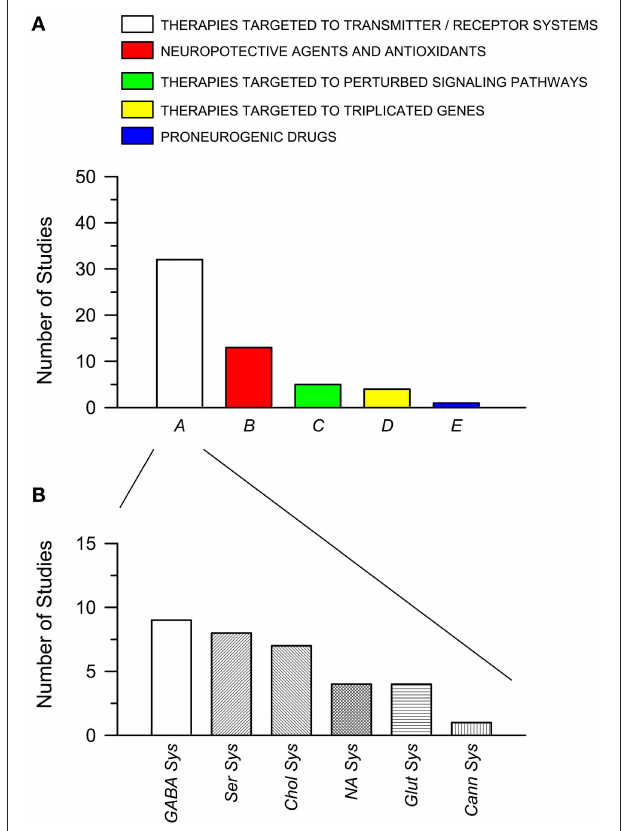
FIGURE 2 | Pharmacotherapies used in the Ts65Dn mouse models of Down syndrome grouped per class. (A) Pharmacotherapies grouped into five classes (A–E) , as explained in the text. The histogram shows the number of published studies for each class. (B) Number of studies for each subclass of pharmacotherapies belonging to class A (see text for explanation). Abbreviations: Cann Sys, cannabinoid sysem; Chol Sys, cholinegic system; GABA Sys, GABAergic system; Glut Sys, glutamatergic system; NA Sys, noradrenergic system; Ser Sys, serotonergic system.